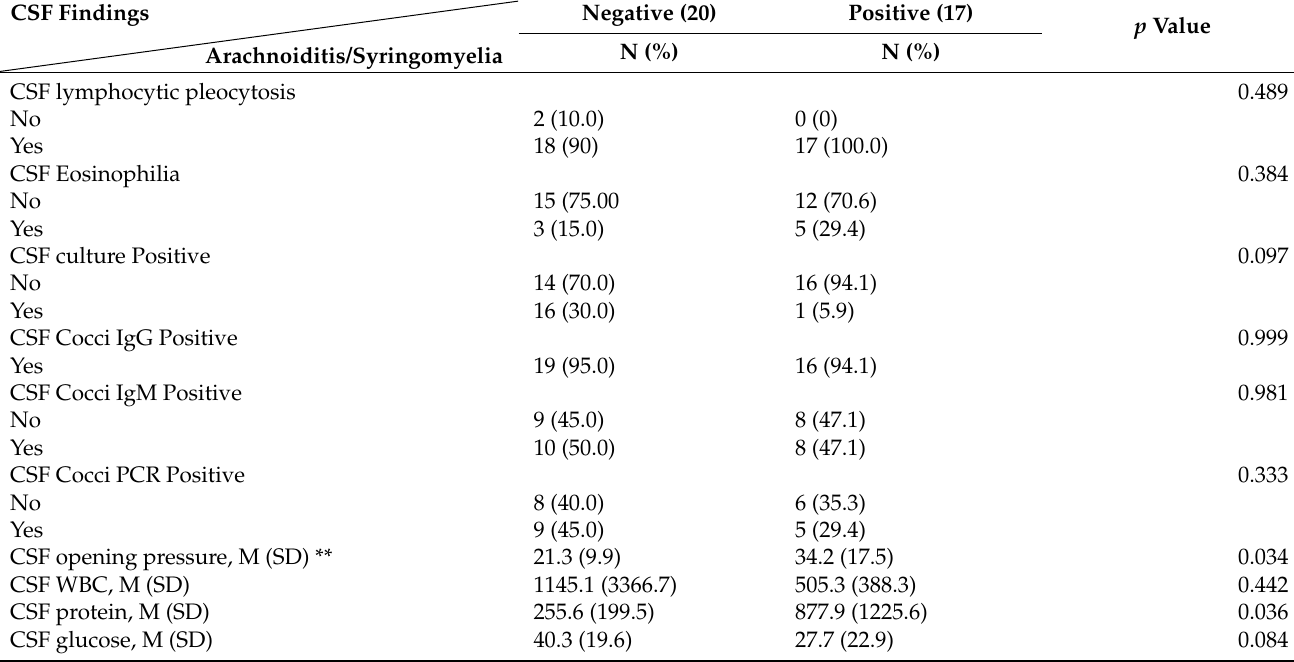
Table 3. CSF findings at diagnosis of CM * in patients with and without changes of arachnoidi-